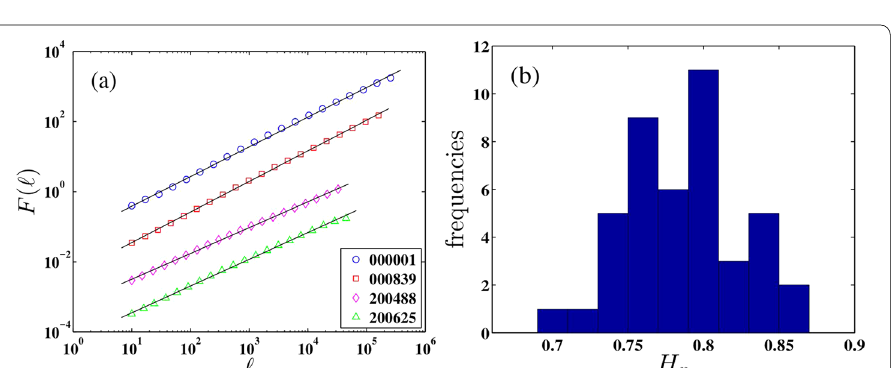
Fig. 3 Long memory in relative order prices. a Plots of the fluctuation functions F (ℓ) of relative order prices for four stocks 000001, 000839, 200488 and 200625. The solid lines are the least squares fits to the data. The scaling curves for 000839, 200488 and 200625 have been shifted vertically for clarity. b Histograms of Hurst exponents H x of relative order prices for all the 43